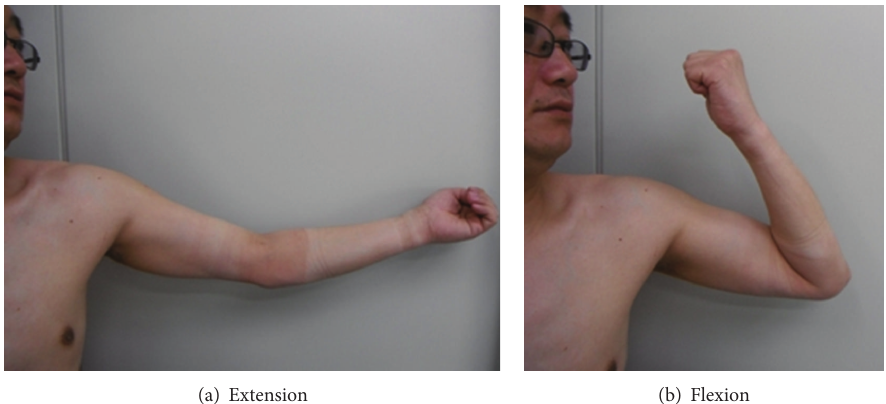
Figure 6: One year after the operation: (a) extension; (b) flexion.